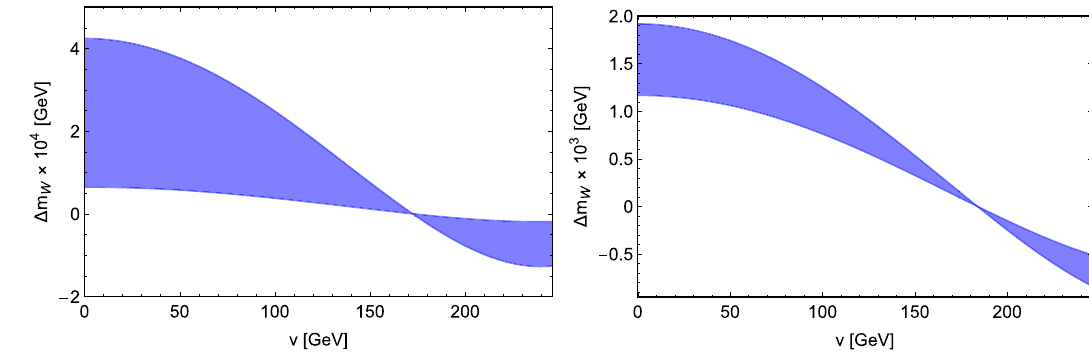
Fig. 2 S , T , and U parameters plotted as functions of v , where the upper panels (the lower panels) correspond to the 3-3-1 model with β = − 1 / −√ ( β = 3), and w is free to float in the range 3 . 9–10 TeV (3 . 9–5 TeV), as appropriate